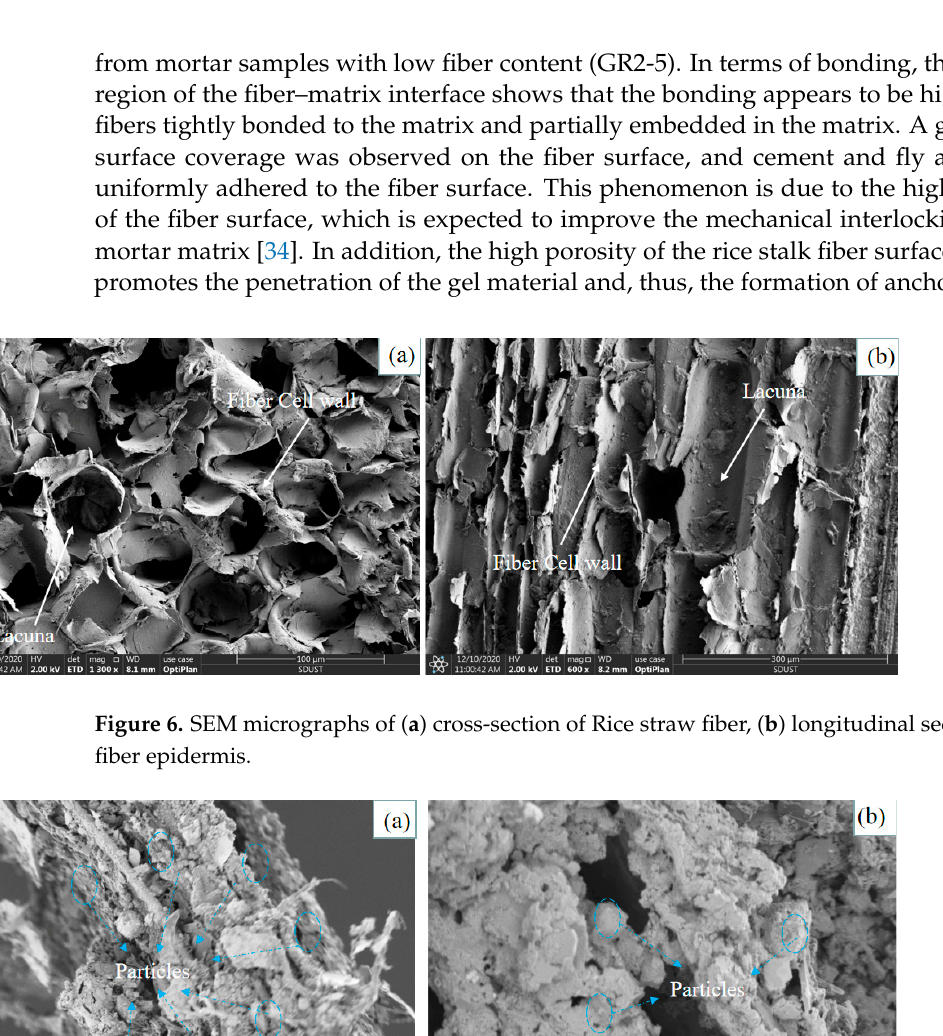
Figure 7. Fiber–matrix binding interface (left) and fiber surface (right) of ( a ) SEM micrographs of the mortar with 2% fibers and ( b ) SEM micrographs of the mortar with 6% fibers.